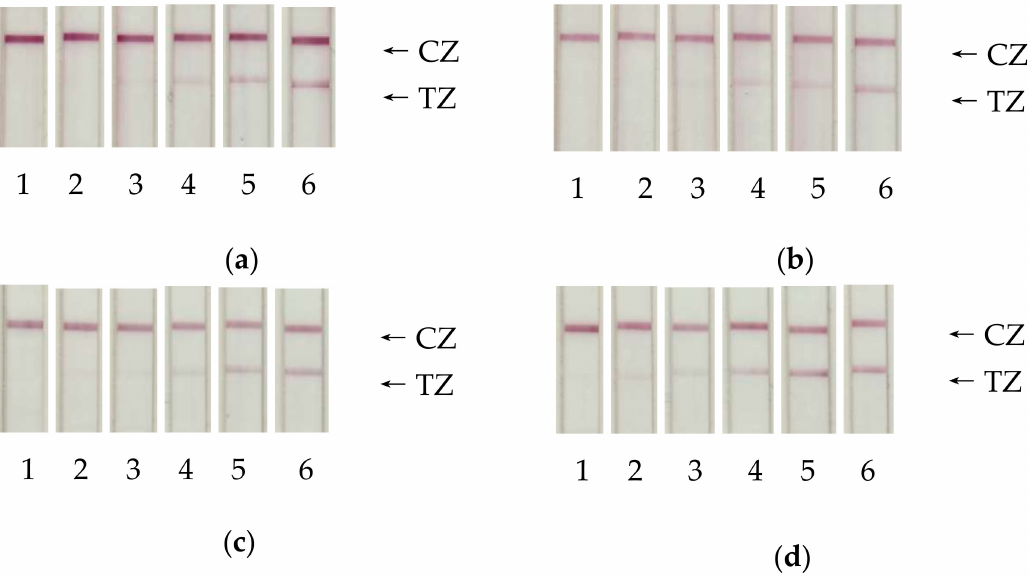
Figure 3. Images of test strips after immunochromatographic detection of cTnI at concentrations of 0.3 (1), 1 (2), 3 (3), 10 (4), 30 (5), and 100 (6) ng / mL. Panels ( a , b ) correspond to the conjugate C-GNPs-3 (33.7 nm)–IC4; ( c , d ) correspond to the conjugate S-GNPs-4 (64.5 nm)–IC4. Panels ( a , c ) correspond to adsorption immobilization of antibodies, ( b , d ) to covalent immobilization of antibodies. CZ: control zone, TZ: test zone.